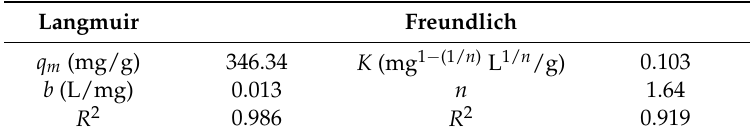
Table 2. Parameters of the Langmuir and Freundlich models for the adsorption of Cr(VI) on MFNNs. Langmuir